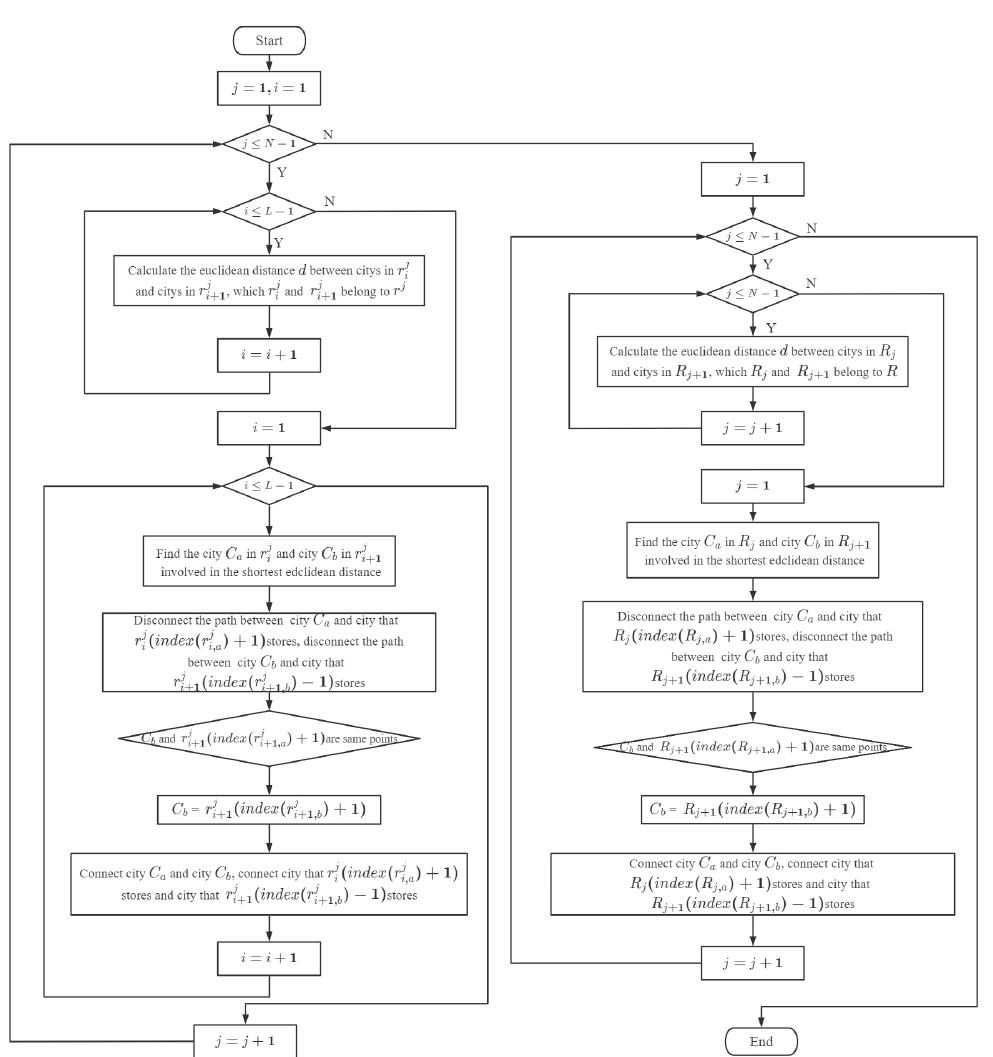
Figure 4. Three-layered structure and city groups connection